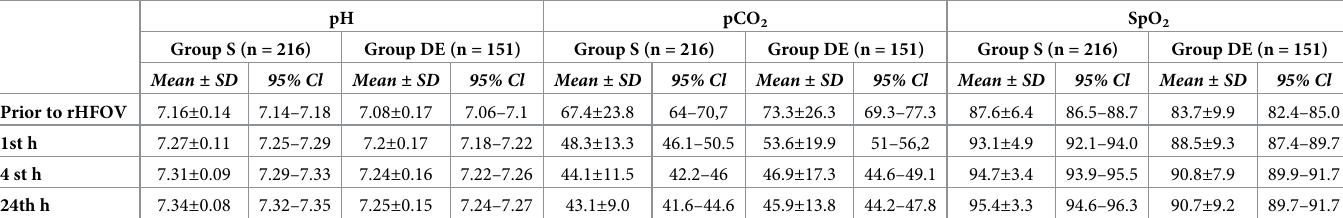
Table 2. pH, pCO 2 and SpO 2 analysis of groups.